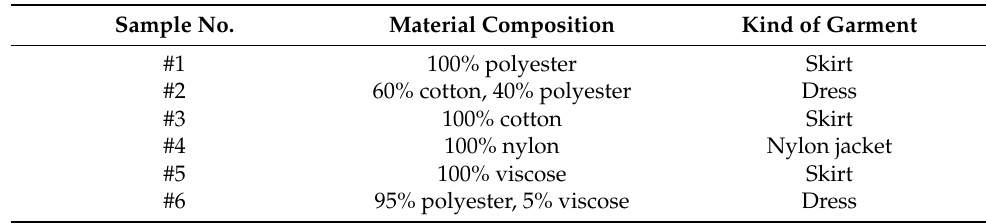
Table 1. Set of material samples for preliminary experiment. Sample